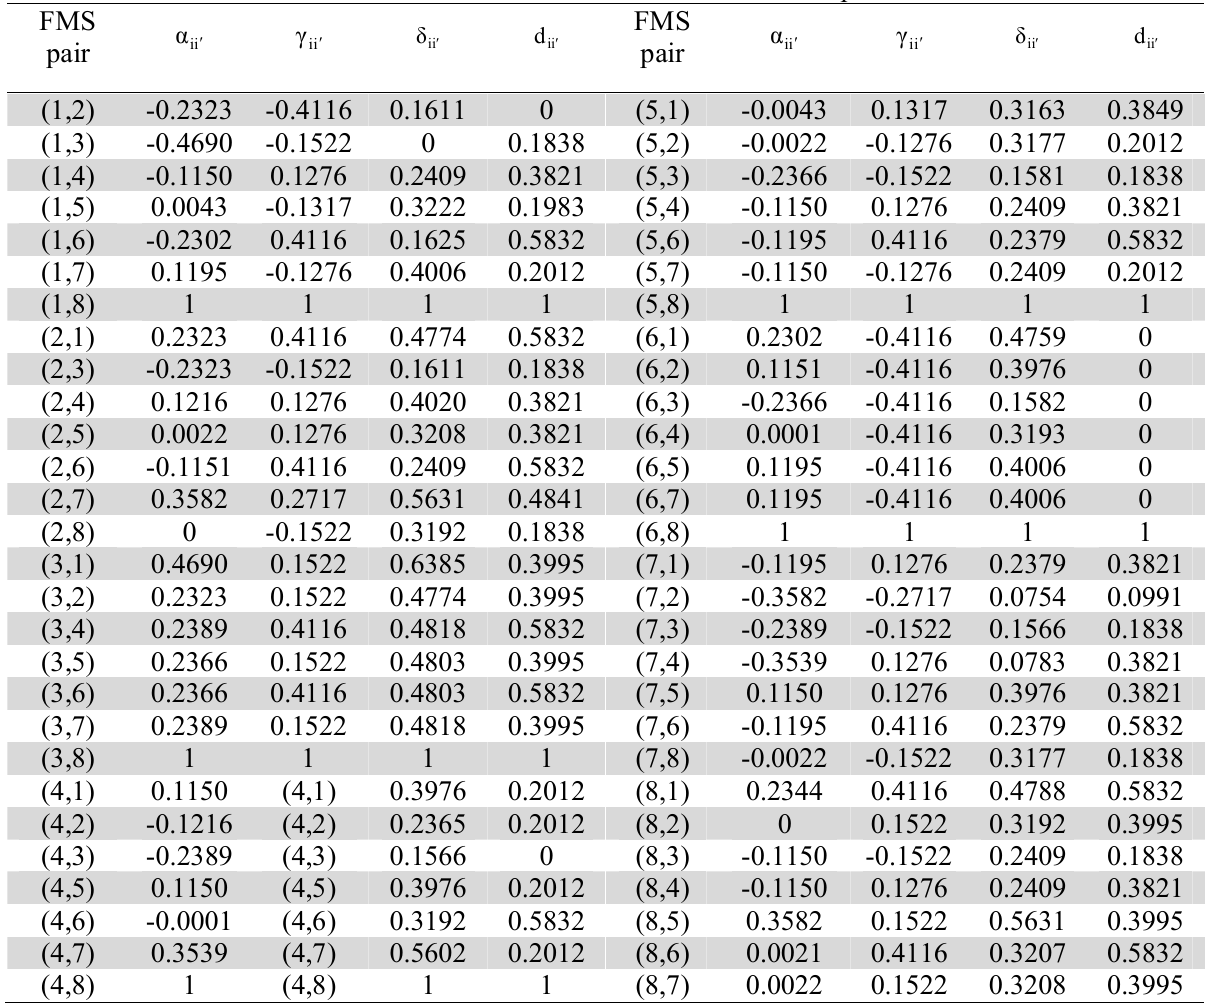
Dominance and standardized dominance scores of each alternative FMS pair